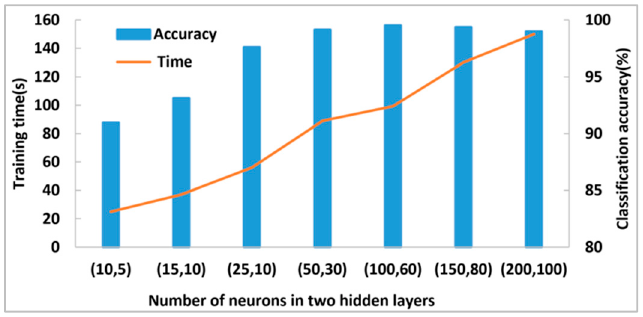
Figure 17. Effect of the number of neurons in two hidden layers.